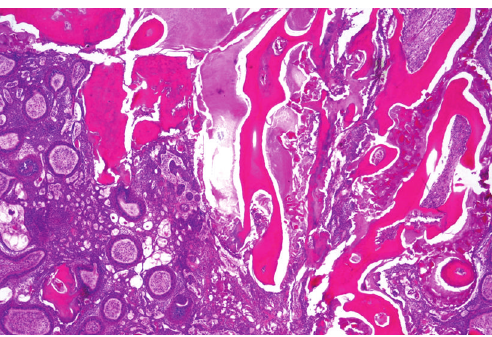
Figure 5: Alveolar tooth socket thickened due to formation of torus. The torus consists entirely of lamellar bone. At the left side the periodontal ligament space with the tooth surface are